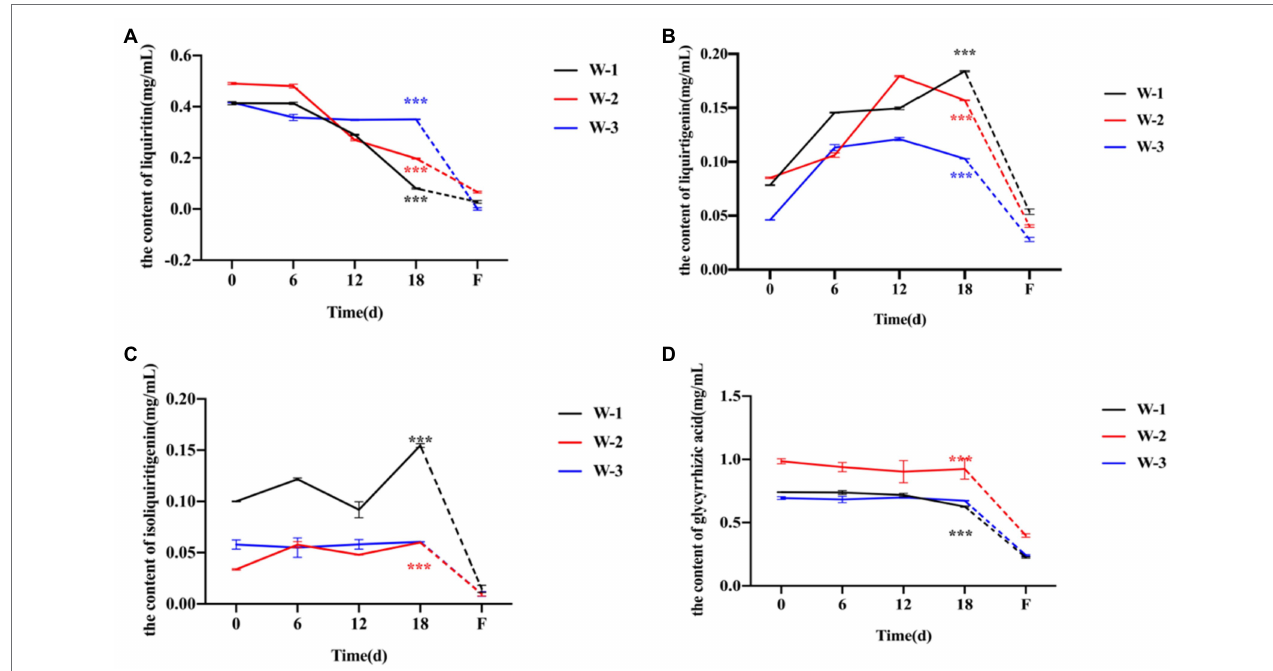
FIGURE 1 | Dynamic changes in the active ingredient content of licorice every 6 days during the natural drying process. (A) Dynamic changes in liquiritin content during different drying periods. (B) Dynamic changes in liquiritigenin content during different drying periods. (C) Dynamic changes in isoliquiritigenin content during different drying periods. (D) Dynamic changes in glycyrrhizic acid content during different drying periods. The dotted line indicates that the licorice is moistened again after drying for a long time, and *** of different colors indicates a significant difference between fresh and completely dried components of different groups, p < 0.01. Each sample was made by mixing five licorice roots, and the measurement was repeated five